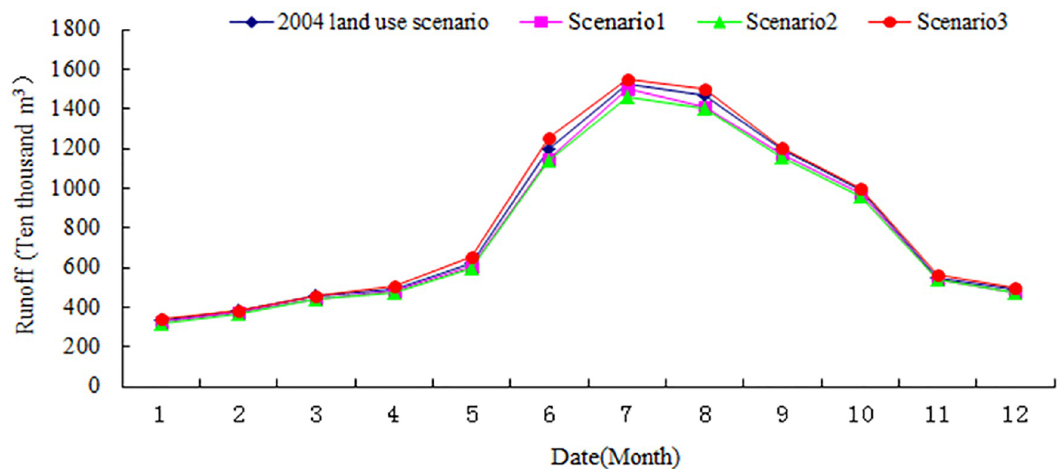
Fig 3. Comparison of runoff under different land use